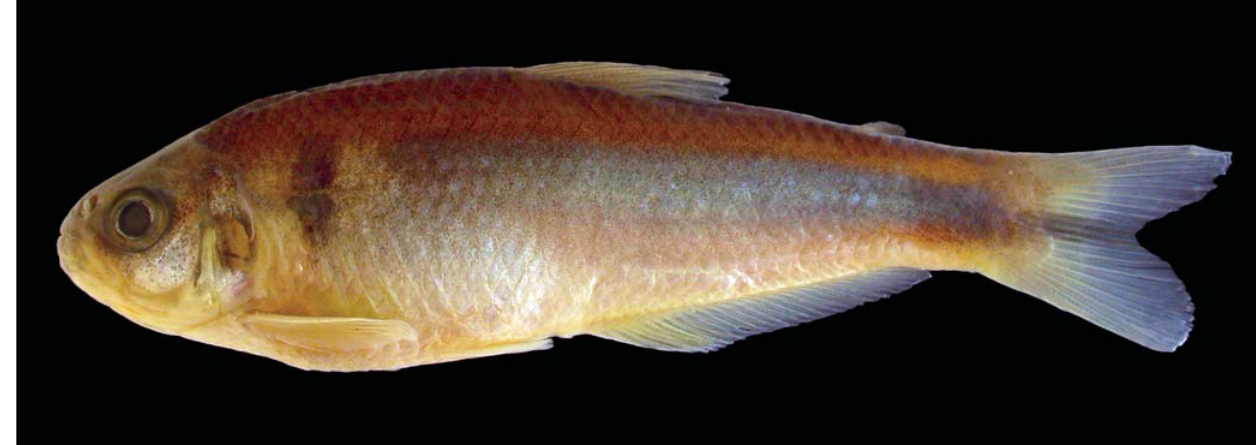
Fig. 10. Hemibrycon inambari , MUSM 35491, holotype, male, 65.4 mm SL, upper río Madre de Dios basin, Peru.